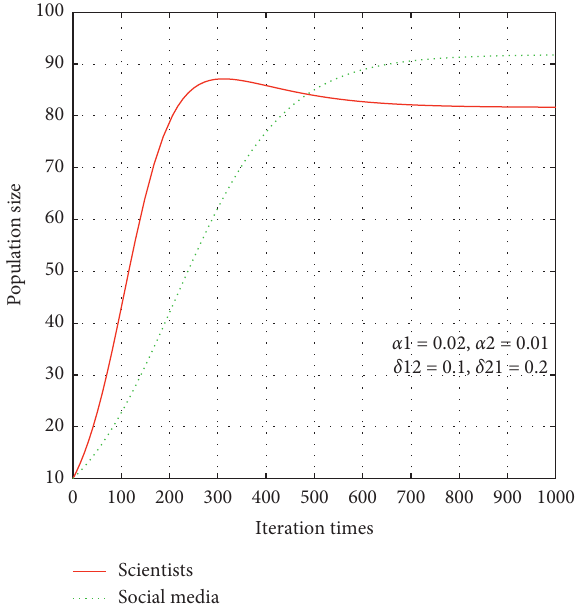
Figure 4: Competitive coexistence pattern. Changes in the size of the two populations after 1000 iterations ( α � 0 . 1, and δ � 0 . 2). δ 12 21